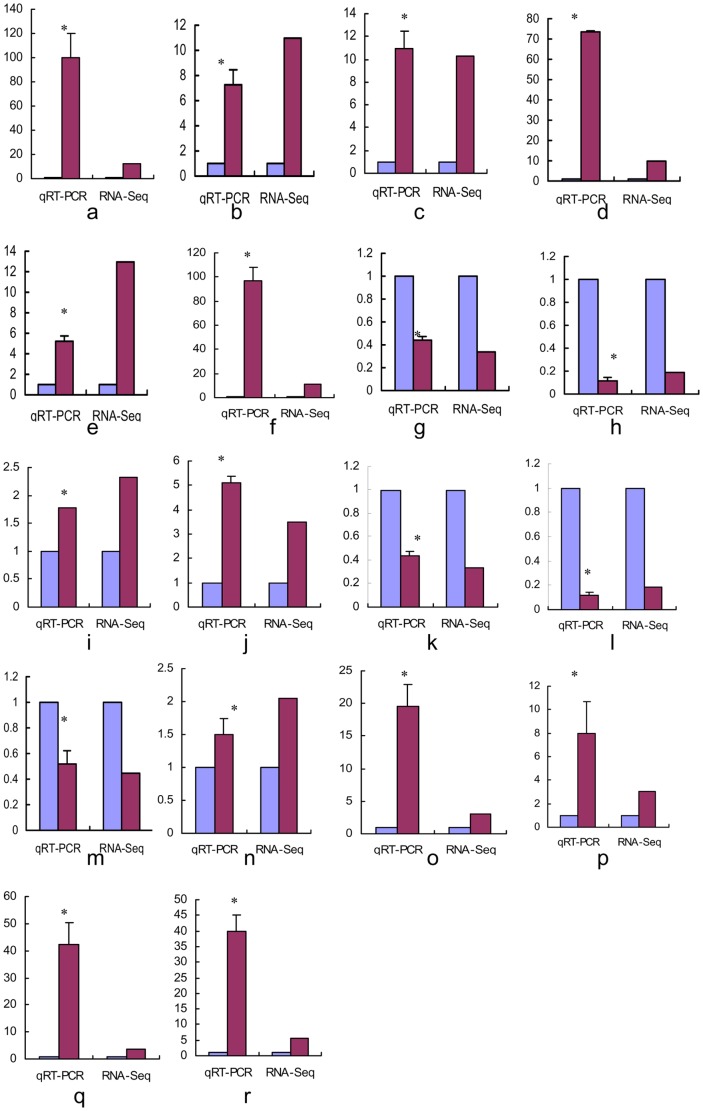
qRT-PCR validation of 18 genes that were differentially expressed between gill and swimbladder.Dark red indicates the tissue of gill and medium slate blue indicates the swimbladder. a, Rh type C glycoprotein2; b, Ras-related protein Rab-19-like; c, Claudin-8-like; d, NAD(P)H dehydrogenase, quinone 1; e, Transmembrane protease serine 11D-like; g, Transmembrane protease serine 9-like; h, Trypsin-like; I, Transcription factor 21-like; j, Minichromosome maintenance complex component 4; k, IL2-inducible T-cell kinase; l, Microphthalmia-associated transcription factor; m, Nuclear receptor subfamily 4, group A, member 2; n, Tetraspanin 11; o, Ankyrin repeat domain-containing protein SOWAHA-like; p, Eukaryotic translation initiation factor 4A2; q, Kelch-like protein 13-like; r, Indian hedgehog protein-like; s, Neuromedin U receptor 1. Asterisk indicates statistical significant level of P<0.05.